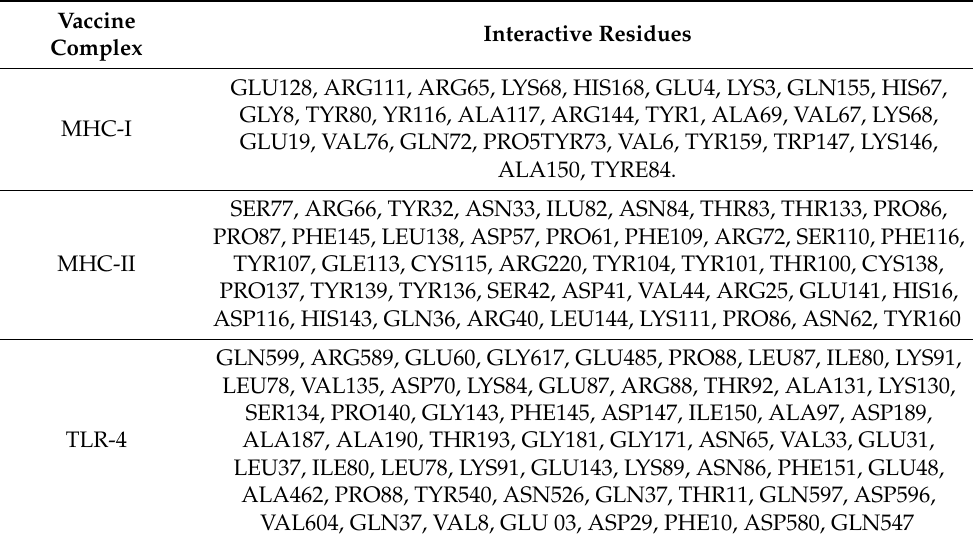
Table 3. Residue-wise interactions of vaccine to MHC-I, MHC-II, and